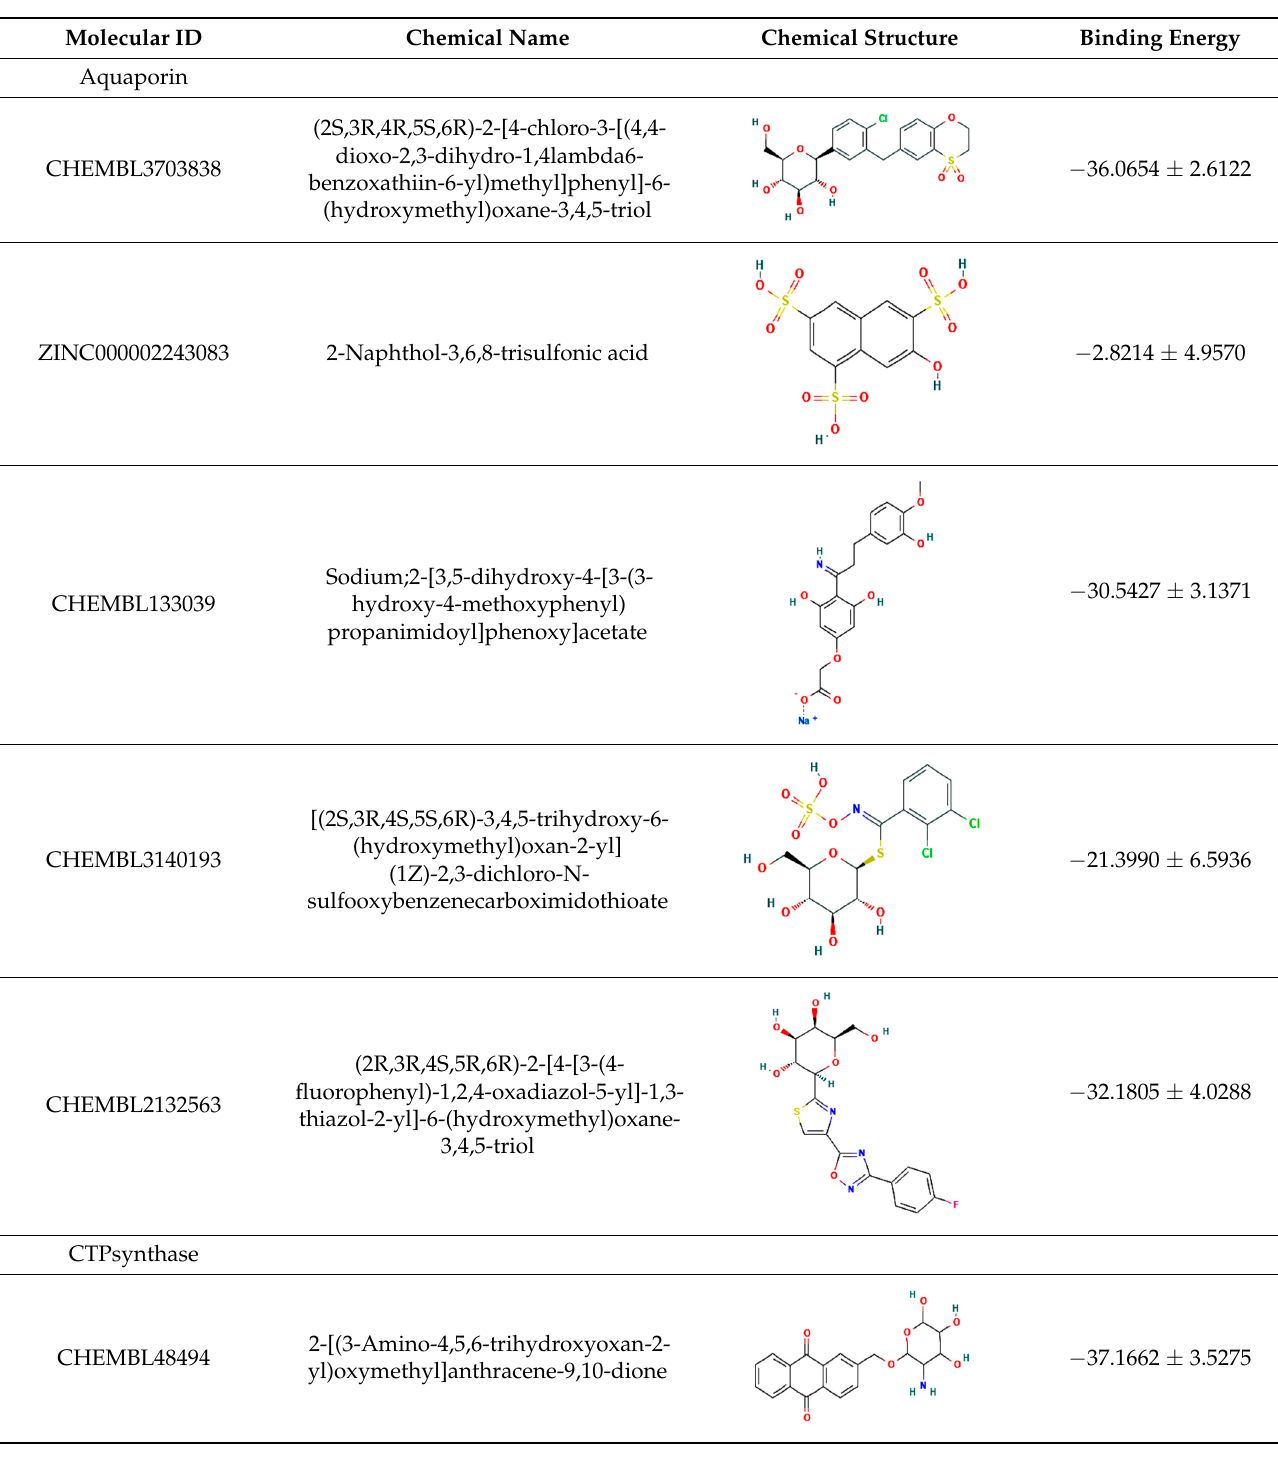
Table 4. The two-dimensional structures and binding energies of the best five compounds selected against the target